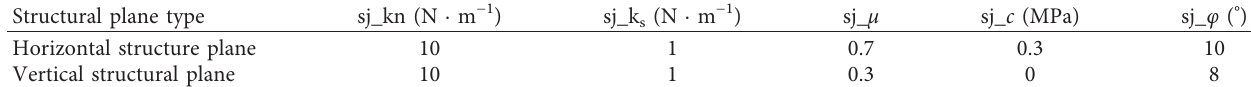
Table 3: Mesoscopic parameters of the structural plane.